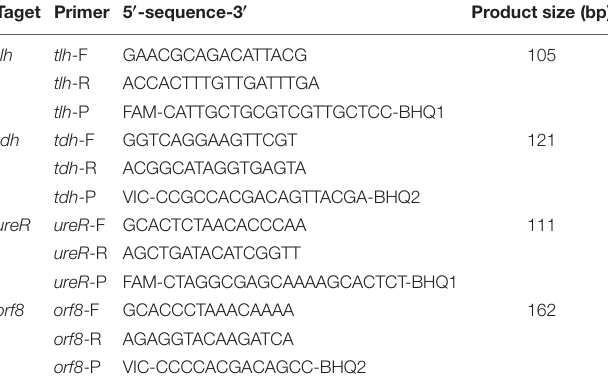
TABLE 2 | Primers and probe sequences used in the 4-plex ddPCR. Taget Primer 5 (cid:48) -sequence-3